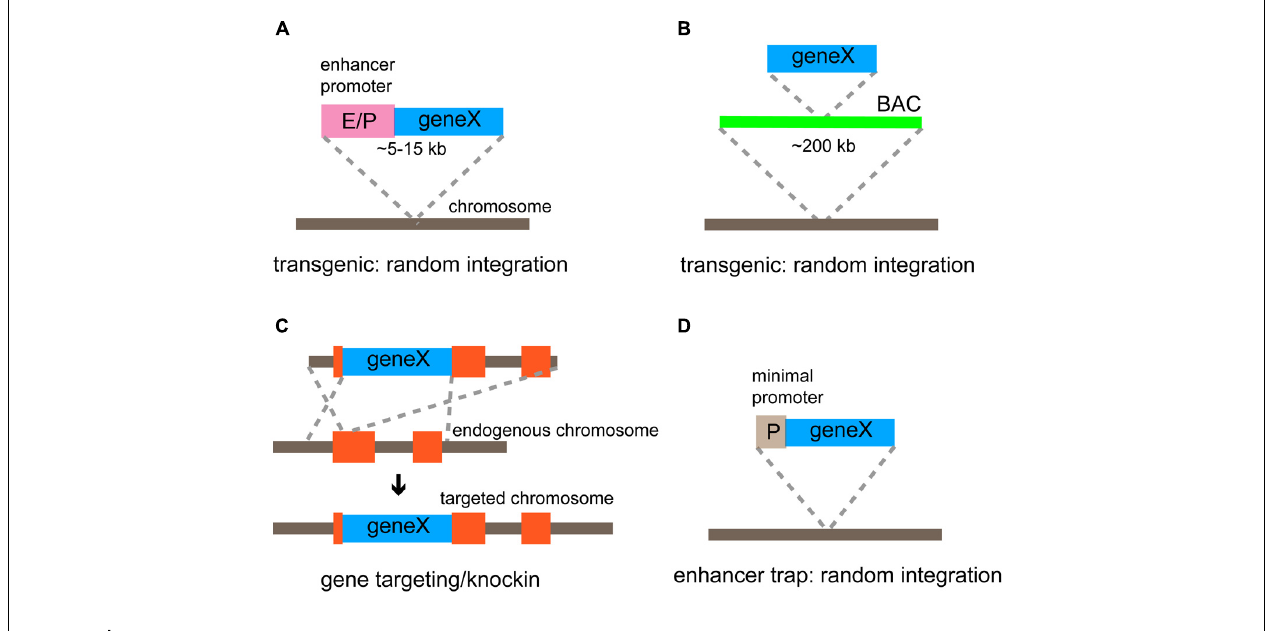
expression pattern of the gene. (C) Gene targeting/knockin approach that is achieved by the homologous recombination. A gene of interest is inserted at the endogenous locus and thus expressed under the control of endogenous gene regulatory elements. (D) Enhancer trap method using a construct comprising a minimal promoter and a gene of interest.The gene is expressed under the control of enhancers that influence its integration